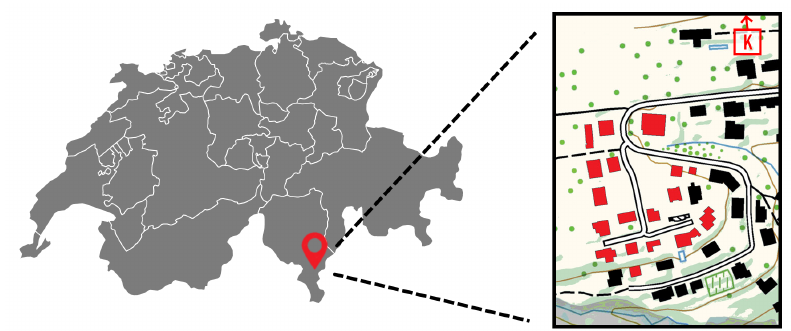
Figure 1. Geographic collocation and map of the LIC energy community in Lugaggia, Ticino, Switzerland. The buildings participating in the community are highlighted in red. The kindergarten is just above the view, indicated with a